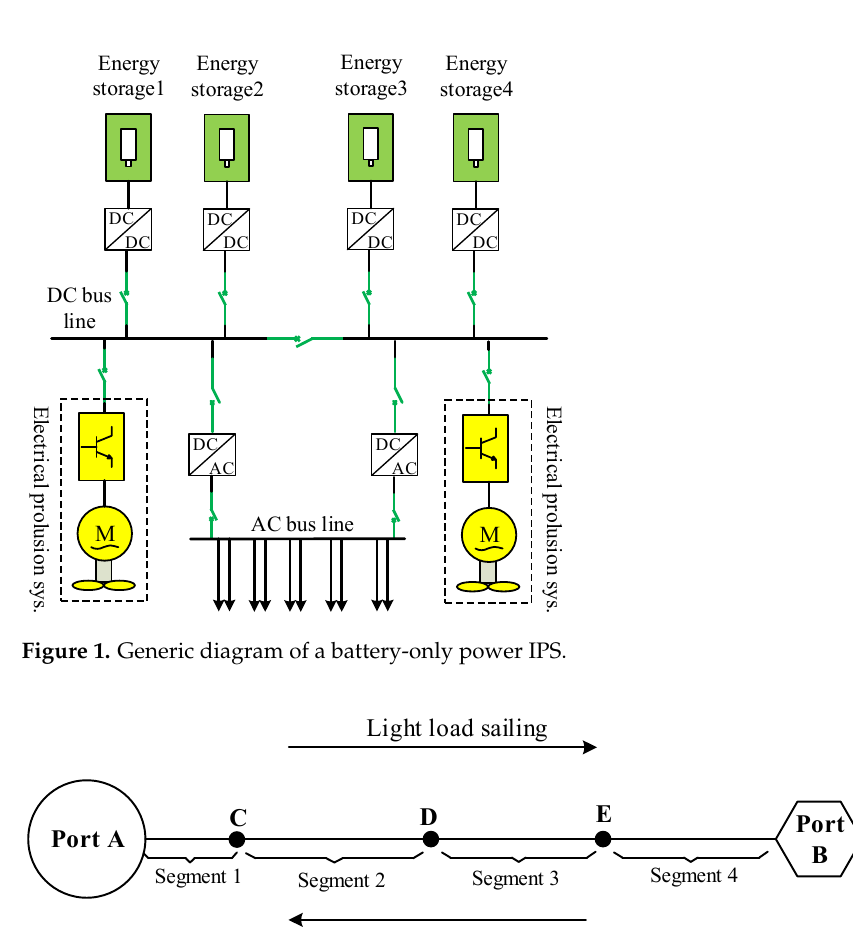
Figure 1. Generic diagram of a battery-only power IPS.